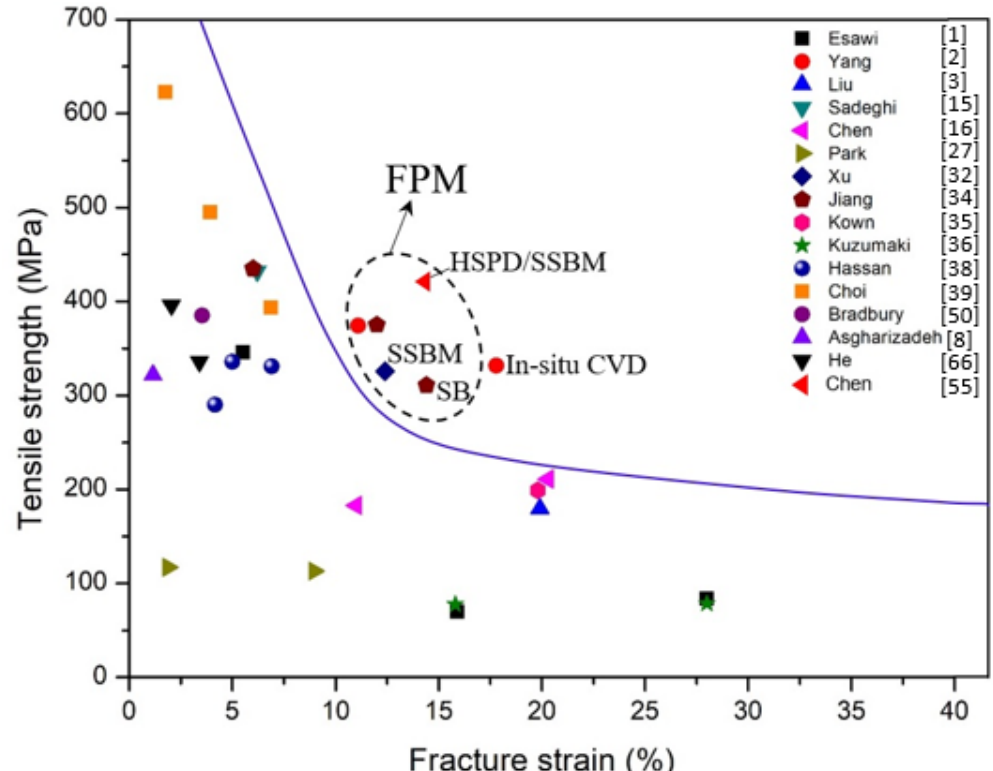
Figure 5. Representative tensile properties of FPM-SSBM CNT/Al composites [27].